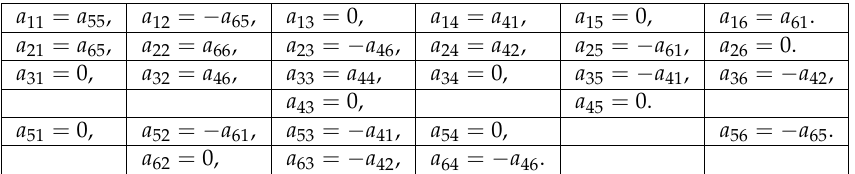
Table 2. Conditions